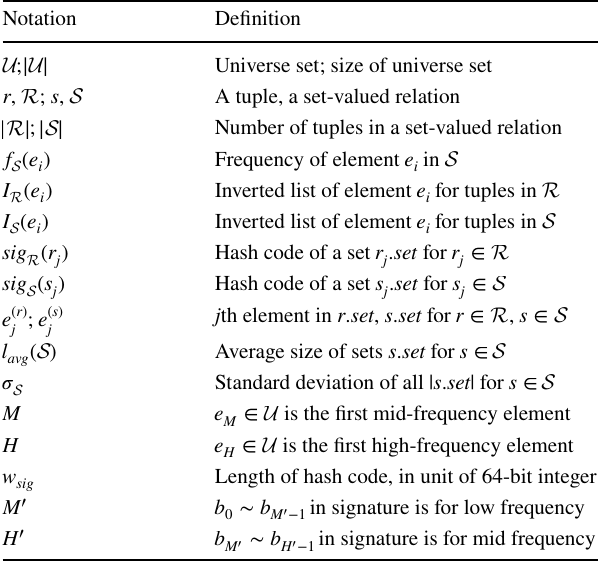
Table 1 Summary of